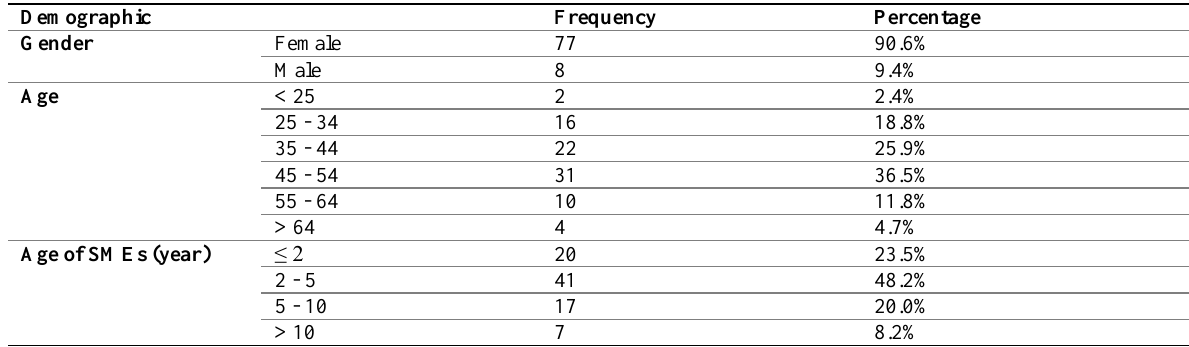
Table 1: Demographic of Respondents